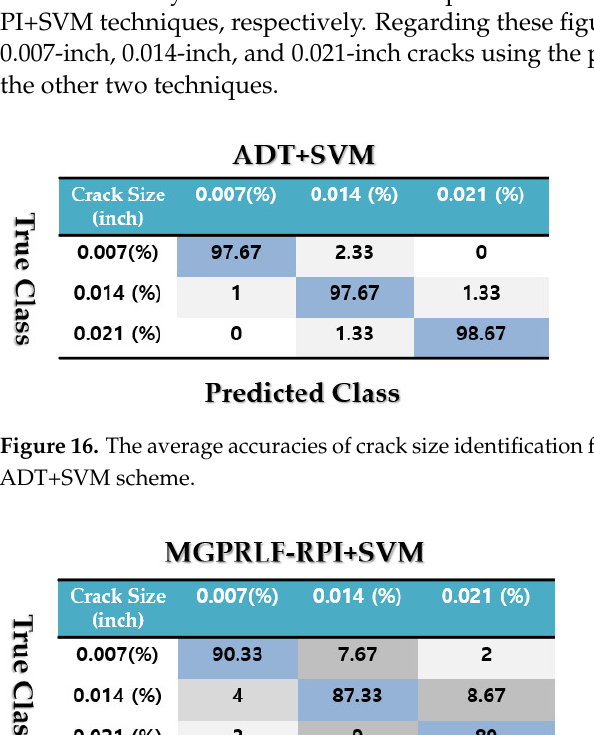
Table 8. The average accuracies of outer crack size identification using the ADT+SVM, MGPRLF- RPI+SVM, and MGPRLF-PI+SVM techniques.